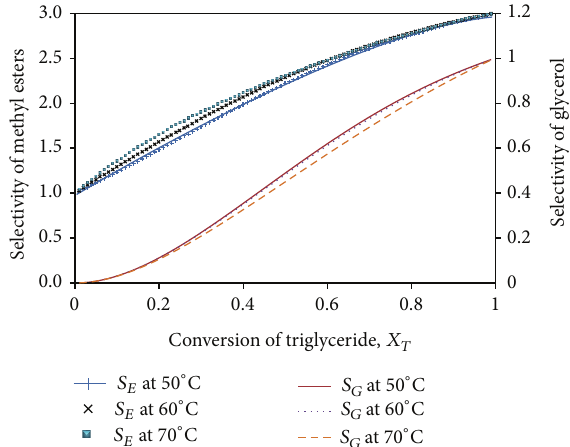
Figure 3: Selectivity of methyl ester at various temperatures and fixed molar ratio and catalyst concentration for Case 1 .